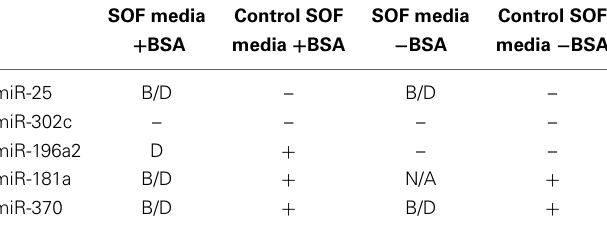
Table 3 | miRNA expression in bovine IVF culture